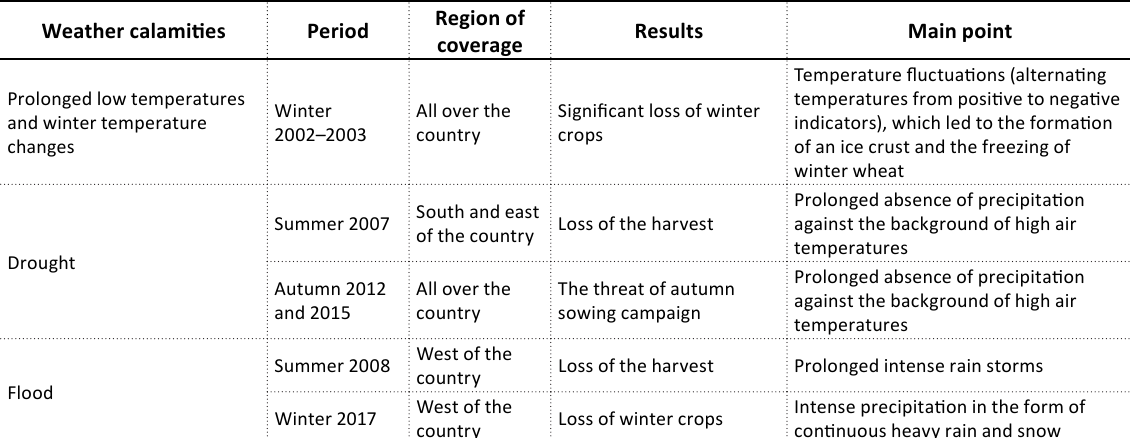
Source: Author’s